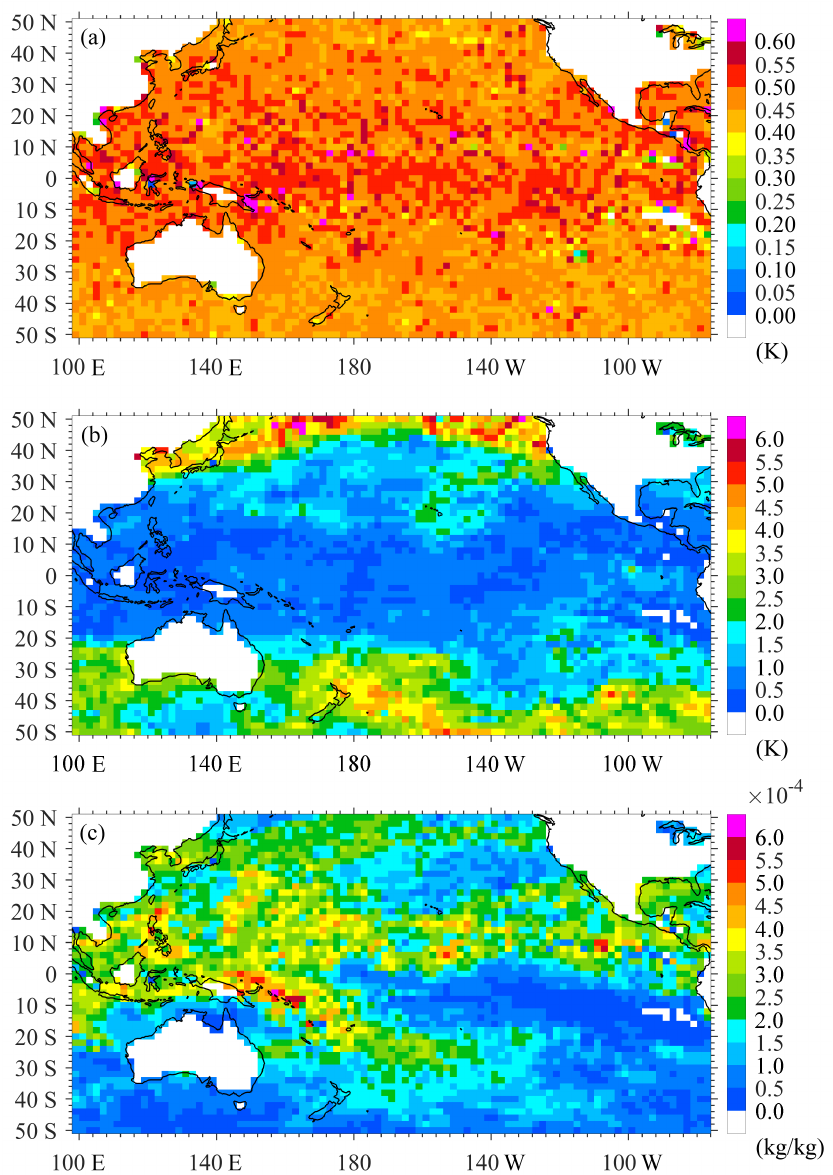
Figure 10. Spatial distribution of: ( a ) “O − B” standard deviation (unit: K) for Channel 6 (WF peaks at 350 hPa); ( b ) variability of atmospheric temperature (unit: K); and ( c ) specific humidity (unit: kg/kg) at 350 hPa of ERA-5 from 24 September to 8 October 2021. The blank boxes in the Eastern Pacific are caused by quality